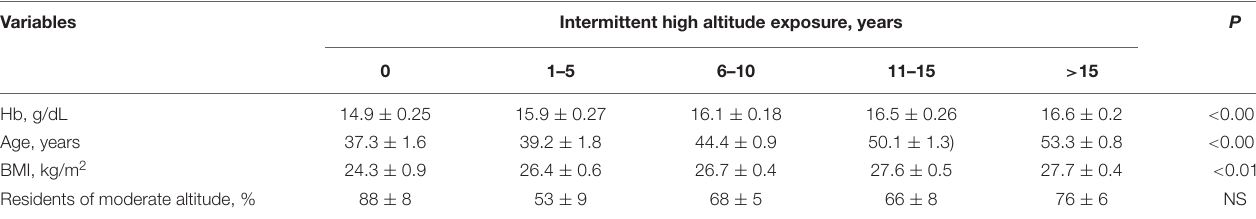
TABLE 2 | Distribution of the hemoglobin levels, age, body mass index, and residence place of the subjects according to the years of high altitude exposure.